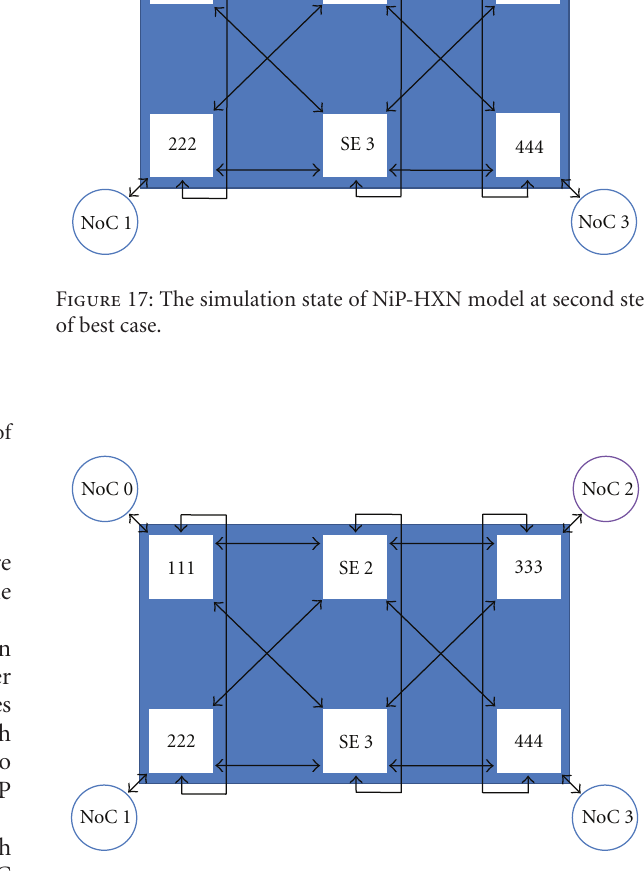
Figure 18: The simulation state of NiP-HXN model at third step of best